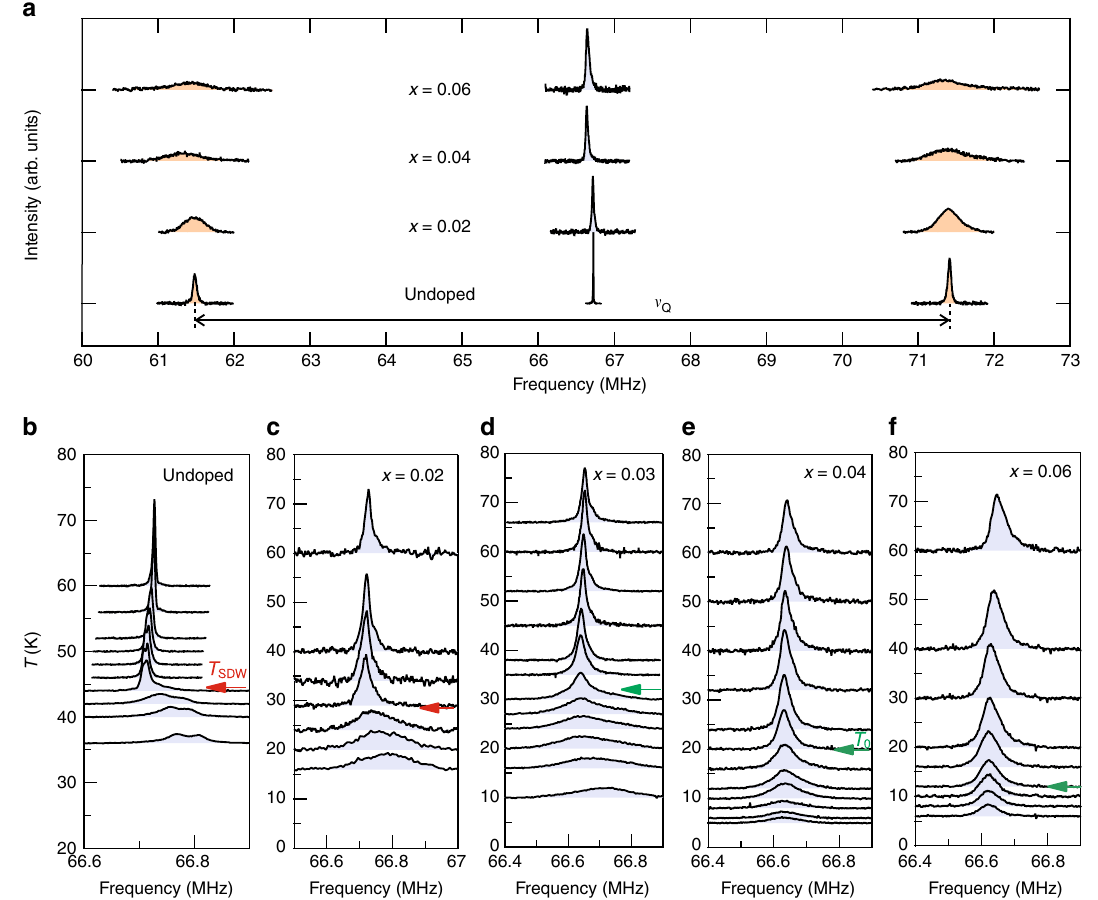
Fig. 2 75 As NMR spectra in Na 1 − x Li x FeAs for for H || ab . a Central and satellite lines of 75 As as a function of doping at a fi xed temperature of 60 K at 9.1 T. While the linewidth of the spectra increases with increasing doping, there is no other lines found and the quadrupole frequency ν Q remains nearly unchanged. b – f Temperature dependence of the 75 As central line as a function of x . For x = 0 and 0.02, the 75 As spectrum starts to broaden and shift to higher frequency below T SDW . In contrast, for x ≥ 0.04, neither a signi fi cant broadening nor a shift of the line was observed, evidencing the absence of static magnetic moments. An inhomogeneous line broadening below T 0 for the intermediate doping x = 0.03 is ascribed to short-range magnetism associated with the charge/orbital ordered phase. The large reduction of the signal intensity below ~10 K is due to bulk